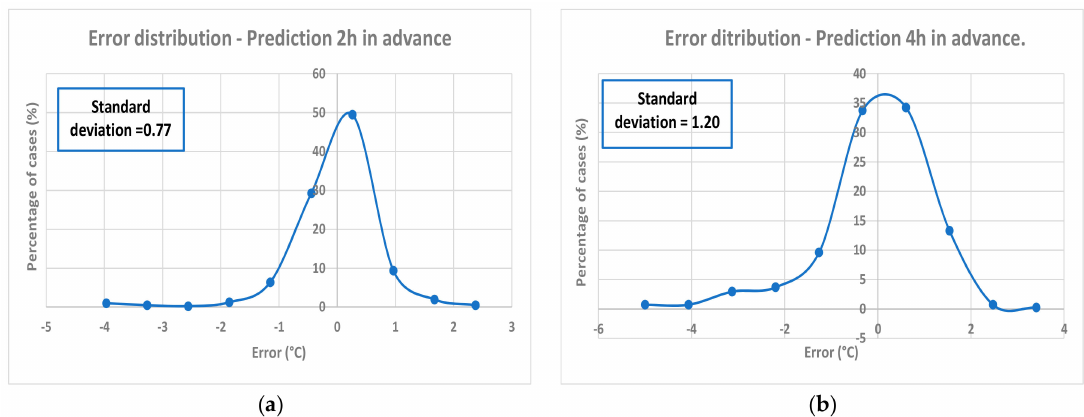
Figure 11. Distribution of error forecasting (input parameter = outdoor temperature and 3-h facade temperature): ( a ) prediction for 2 h; and ( b ) prediction for 4 h. Table 6. Performances of the forecasting models (input parameters = outdoor temperature